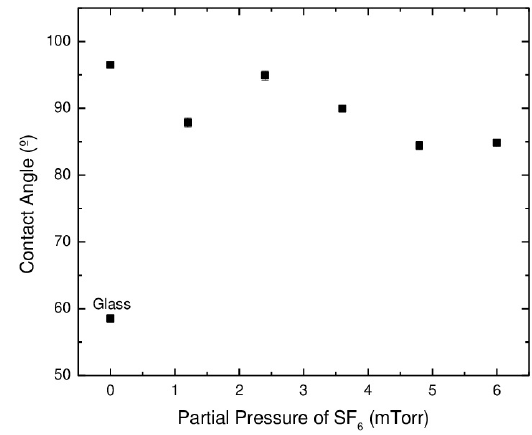
Figure 4. Contact angle as a function of R